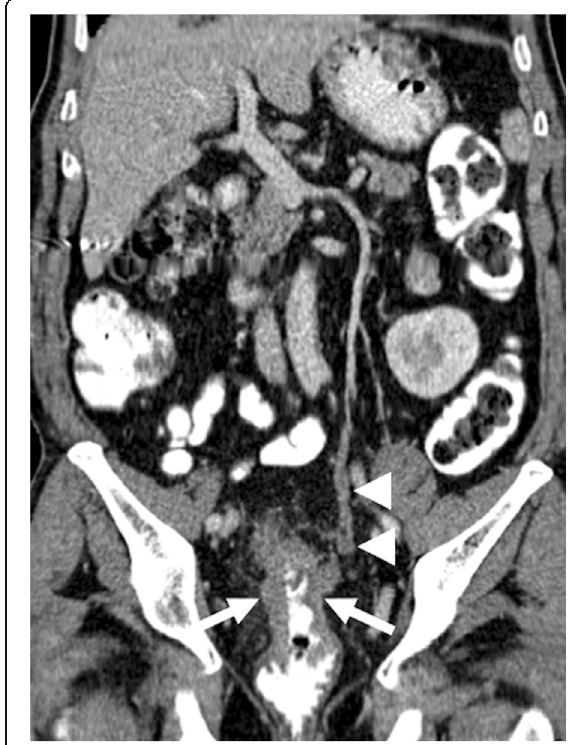
Fig. 18 A 57-year-old male patient with no significant past medical history presented with abdominal pain and hematochezia. Colonoscopic examination and biopsy confirmed adenocarcinoma of the rectum. Coronally reformatted postcontrast CT image demonstrates the primary tumor (arrows) and thrombus within the lumen of the caudal portion of the IMV (arrowheads). Surgical resection and histopathologic examination confirmed the tumoral thrombus in the resected portion of the IMV